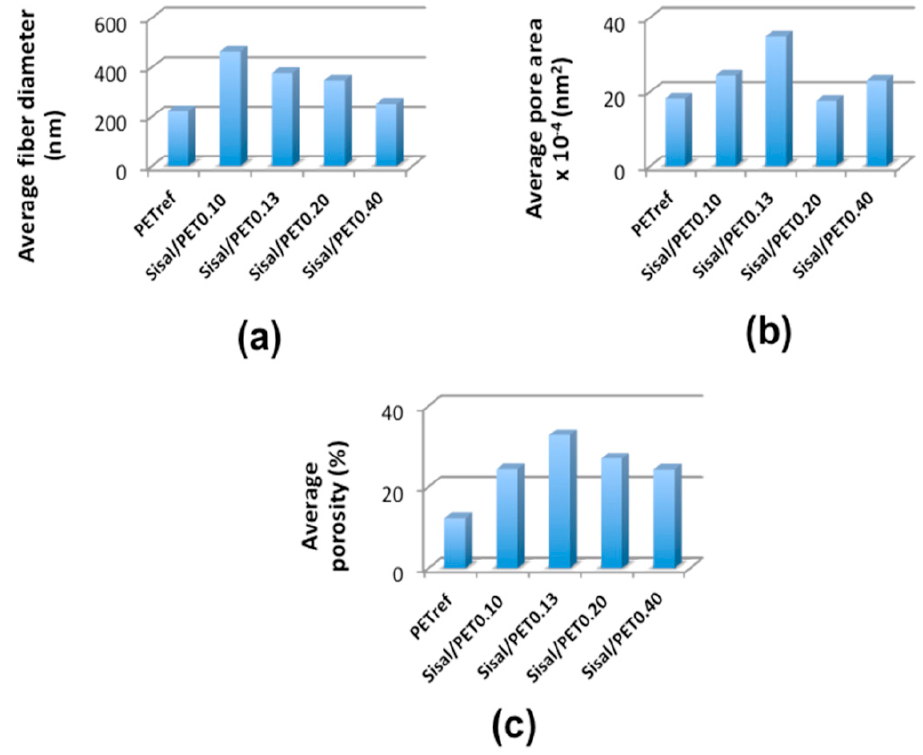
Figure 5. Average values of ( a ) fiber diameter (errors from ±59.10 (PET ref ) to ±160.70 (Sisal/PET 0.20 )); ( b ) pore area (errors from ±1.00 (Sisal/PET 0.10 ) to ±17.80 (Sisal/PET 0.40 )); and ( c ) porosity (errors from ±0.20 (PET ref ) to ±7.10 (Sisal/PET 0.40 )) of the electrospun mats. The alignment index, A.I., ranged from 0.31 ± 0.01 (Sisal/PET 0.13 ) to 0.66 ± 0.08 (PET ref ), Figure